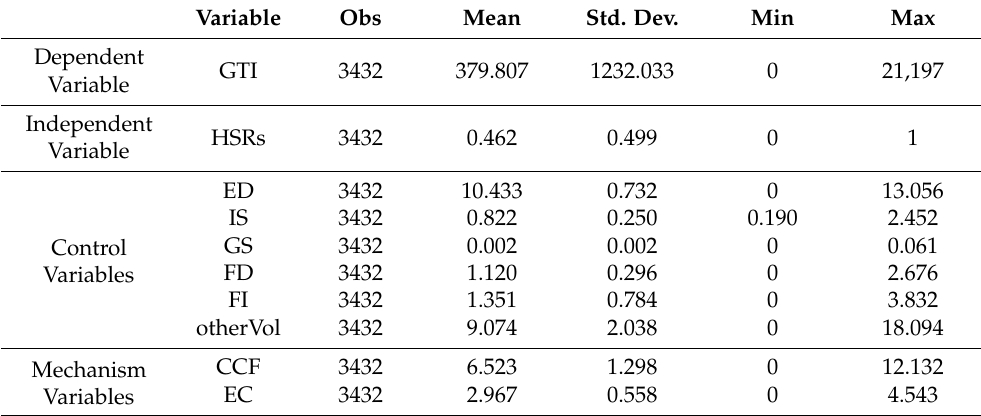
Table 1. Descriptive statistics of main